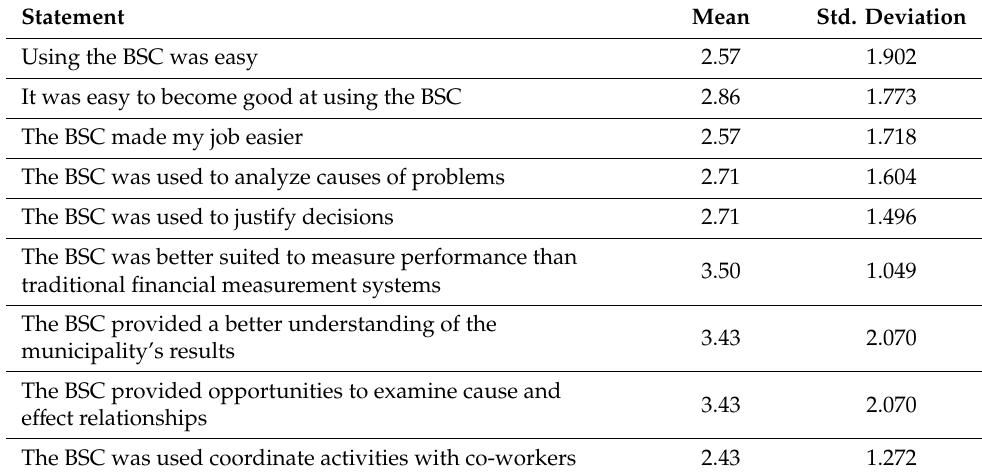
Table 28. Experiences with using the BSC [Scale: 1–7].